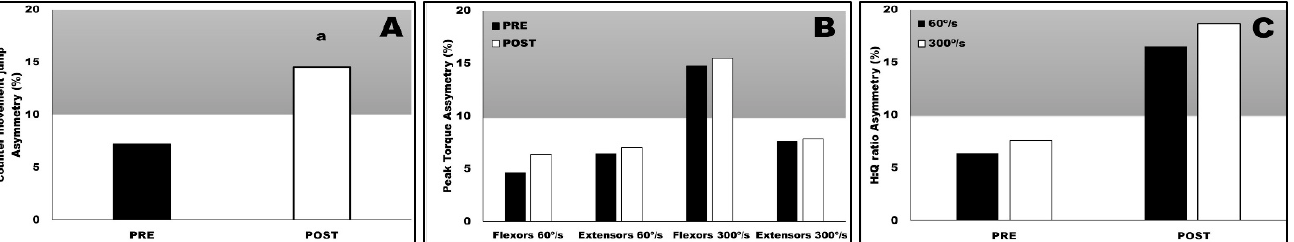
Figure 3. Asymmetry of unilateral CMJ ( A ) and ISK variables (peak torque, total work and average power = ( B )) and H:Q ratio ( C ) at 60°/s and 300°/s in both PRE and POST conditions. DOM = dominant leg; NDOM = nondominant leg; PRE = prior to the competitive season starting; POST = after 15 weeks of a competitive season; a = different than DOM at the same period ( p ≤ 0.05); The gray area (>10%) indicates an injury risk zone.